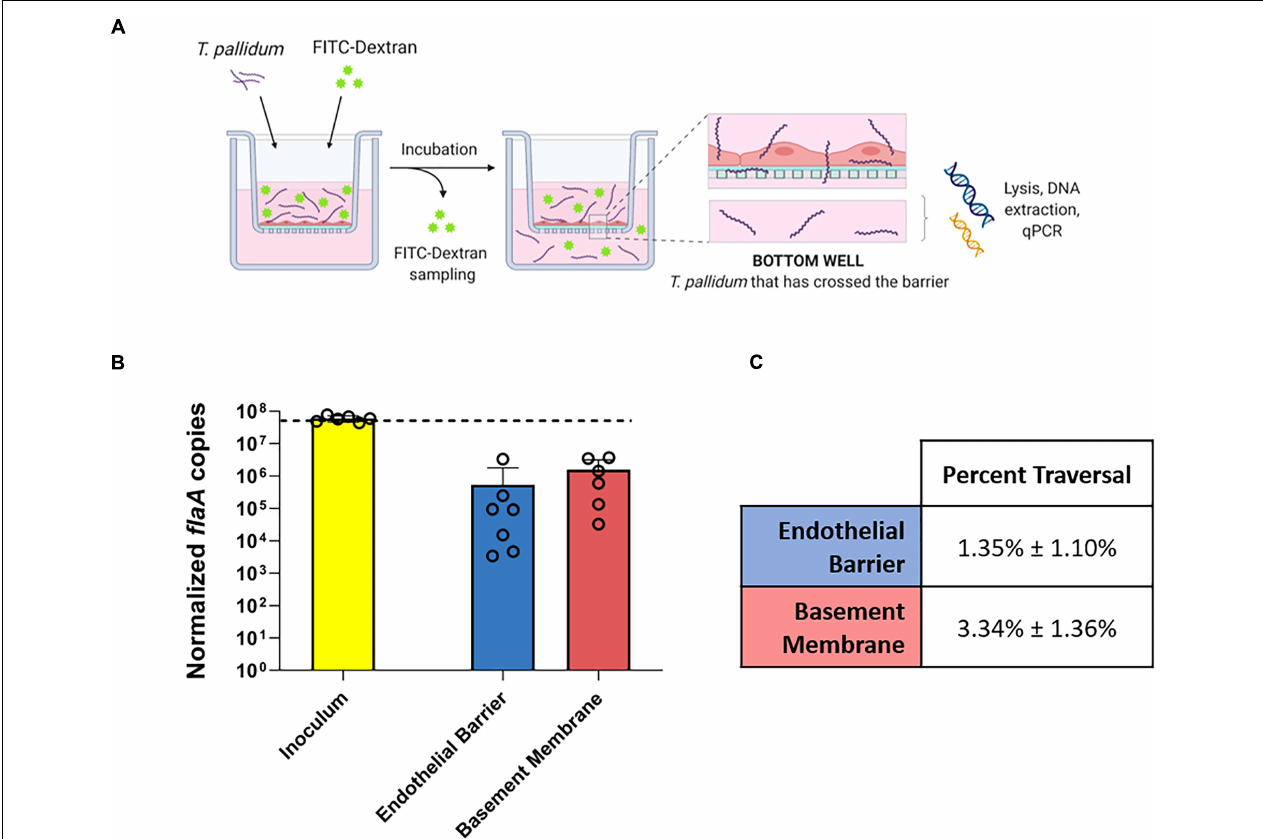
FIGURE 7 | Quantification of T. pallidum traversal across endothelial barriers and basement membranes. (A) Schematic of T. pallidum traversal assay. HUVECs were seeded onto an artificial basement membrane in transwell inserts and grown to confluence. Barrier integrity was confirmed using transendothelial electrical resistance (TEER), where monolayer resistance > 12 (cid:127) × cm 2 dictated an intact monolayer. Barrier permeability was assessed with a transwell solute flux assay, where endothelial permeability in the presence of T. pallidum was monitored with a FITC-dextran fluorescent tracer by sampling from the bottom compartment of the transwell for fluorescence measurements throughout the 4-h period. T. pallidum traversal was evaluated by collecting the media from the lower compartment in each well and quantifying traversal with quantitative polymerase chain reaction (qPCR) detection of endoflagellar sheath gene flaA . Image created with BioRender. (B) Starting inoculum of T. pallidum (yellow) and T. pallidum traversed across endothelial barriers (blue) or basement membranes (red) quantified with qPCR targeting the endoflagellar sheath gene, flaA , normalized to a spiked-in plasmid DNA to control for differences in extraction efficiency. Results presented as mean ± SEM from six independent experiments. (C) Percent traversal of T. pallidum across endothelial barriers or basement membranes relative to the starting